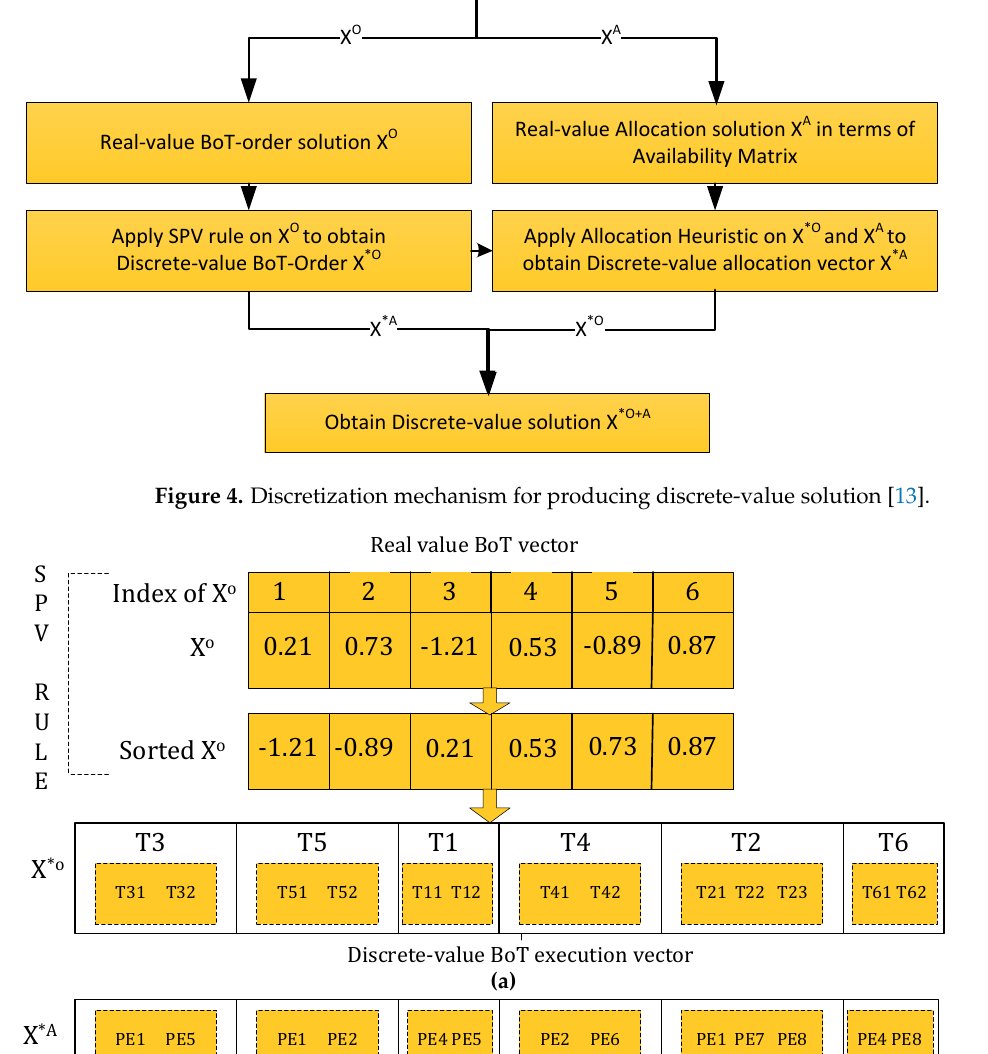
Figure 5. ( a ) Example showing procedure to obtain X ∗ O vector applying SPV method, ( b ) Example showing procedure to obtain X ∗ A vector applying MDeRA